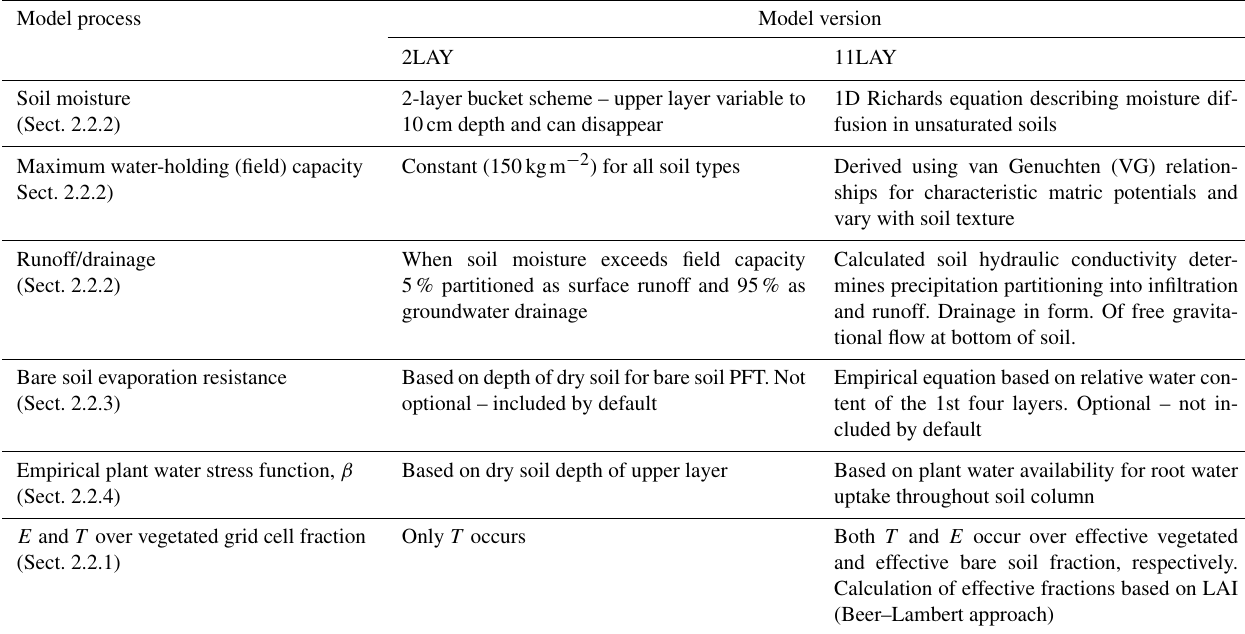
Table 2. Summary of differences between 2LAY and 11LAY model versions. All other parameters and processes in the model, including the PFT and soil texture fractions (Table 1), the vegetation and bare soil albedo coefficients (Sect. 2.2.1), and the multi-layer intermediate- complexity snow scheme (Sect. 2.2.5), are the same in both